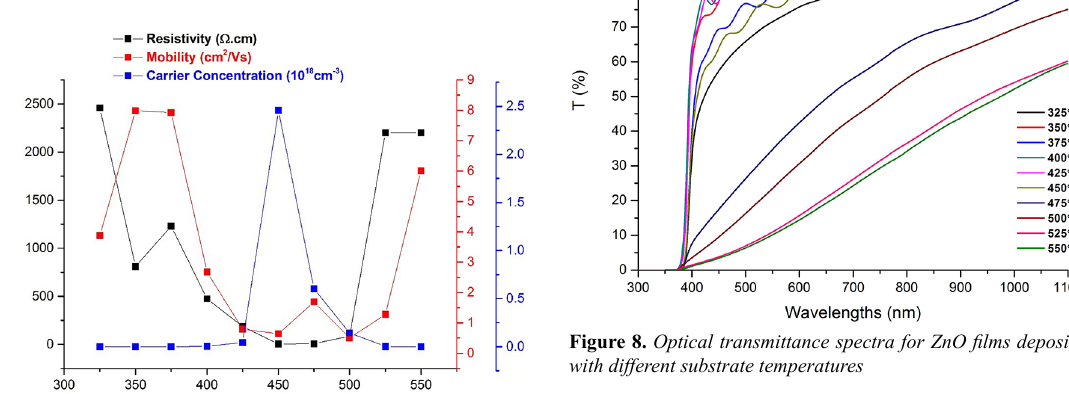
Figure 7. Variations of resistivity, mobility and carrier concentration versus deposition temperature Fig. 8 illustrates the optical transmittance spectra obtained from ZnO thin films, at the wavelengths ranging from 300- 1100 nm, as a function of substrate temperature which plays about 80% in the visible section of the spectrum from 325℃ to transmittance was reduced and we lost most interference fringes.